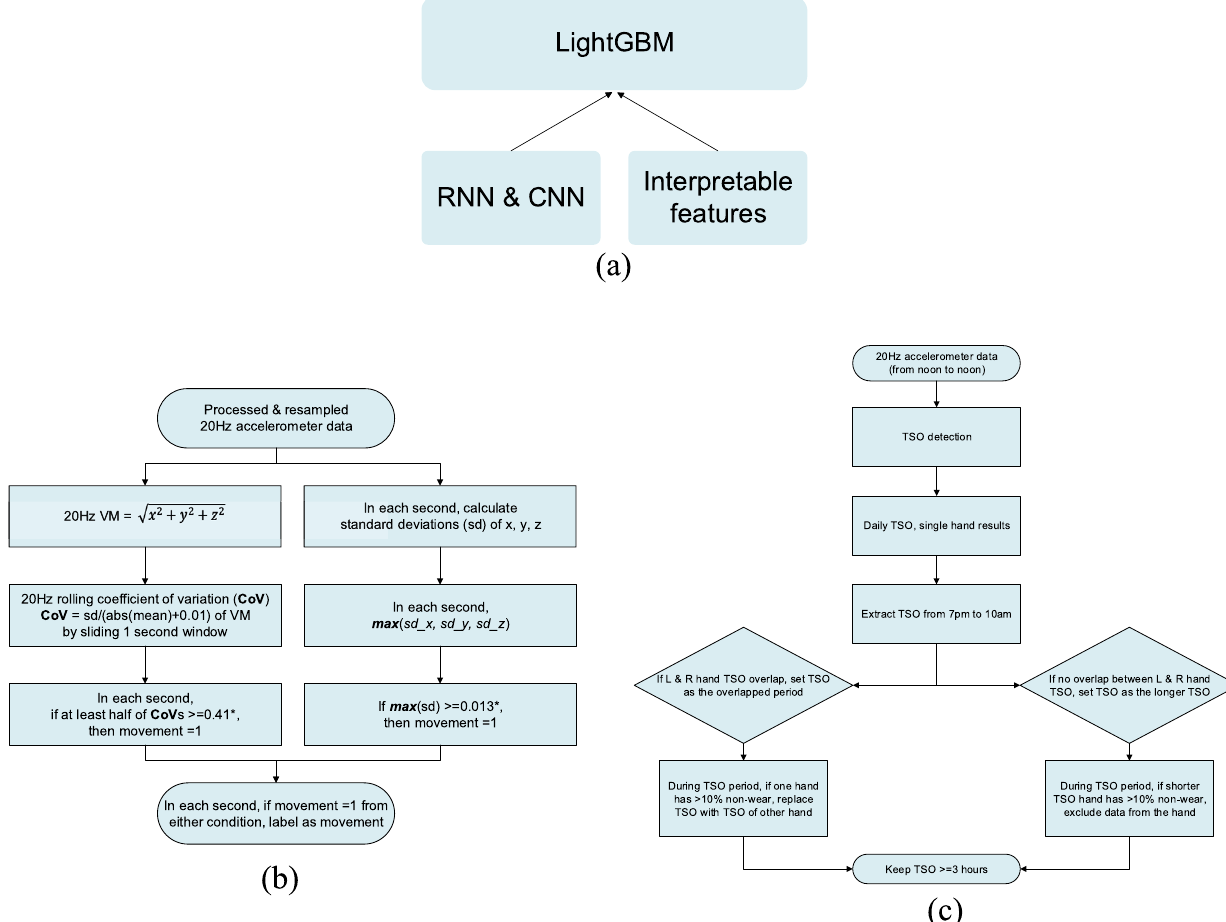
Fig. 7 Detailed diagrams of pipeline. a Ensemble deep learning model with LightGBM. b Movement detection algorithm; * 0.41 and 0.013 were chosen based on quantiles from the entire dataset. c Steps of getting combined TSO from both